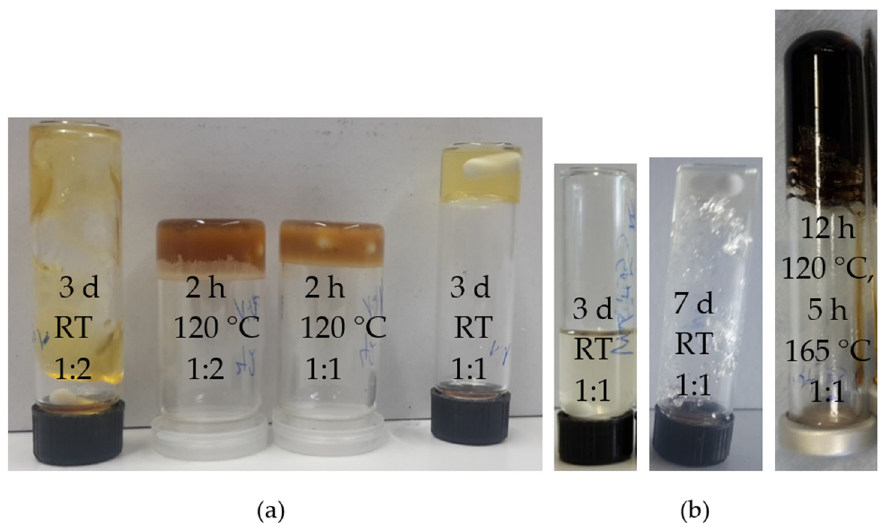
Figure 8. Crosslinked PFMA 5 . ( a ) PFMA 5 with BMI crosslinked at two different temperatures (room temperature (RT) and 120 °C) and two different motif ratios (1:2 and 1:1) in DCM. ( b ) Crosslinked PFMA 5 with P(MMA 74 - co -MIMA 26 ) 9 at two different temperatures (room temperature (RT) in DCM and 120 °C; 165 °C in anisole) and the gelation process at room temperature in DCM after 3 days and 7 days.